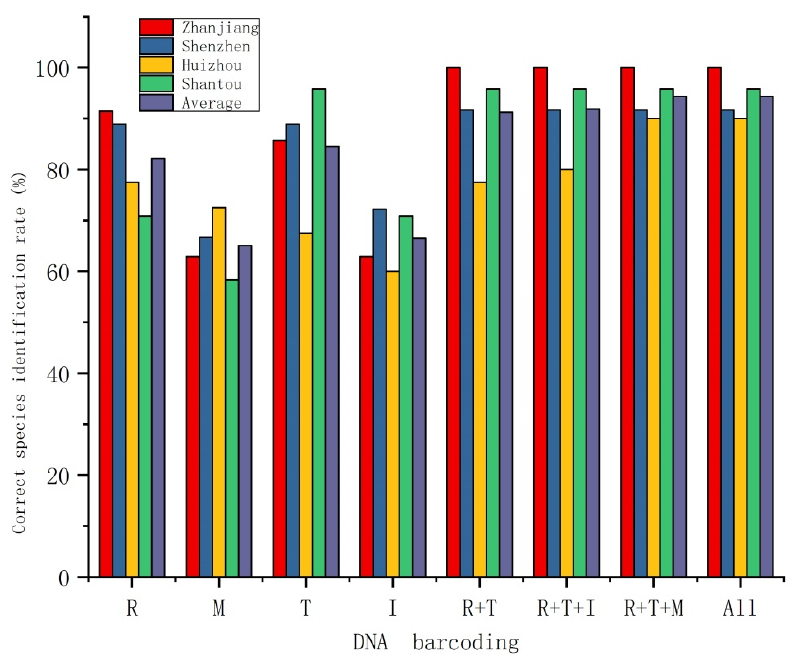
Figure 1. Mangrove species discrimination rate of all single and multi-DNA barcoding fragments. R, rbcL ; M, matK ; T, trnH–psbA ; I, ITS; All, the database consisted of all species.